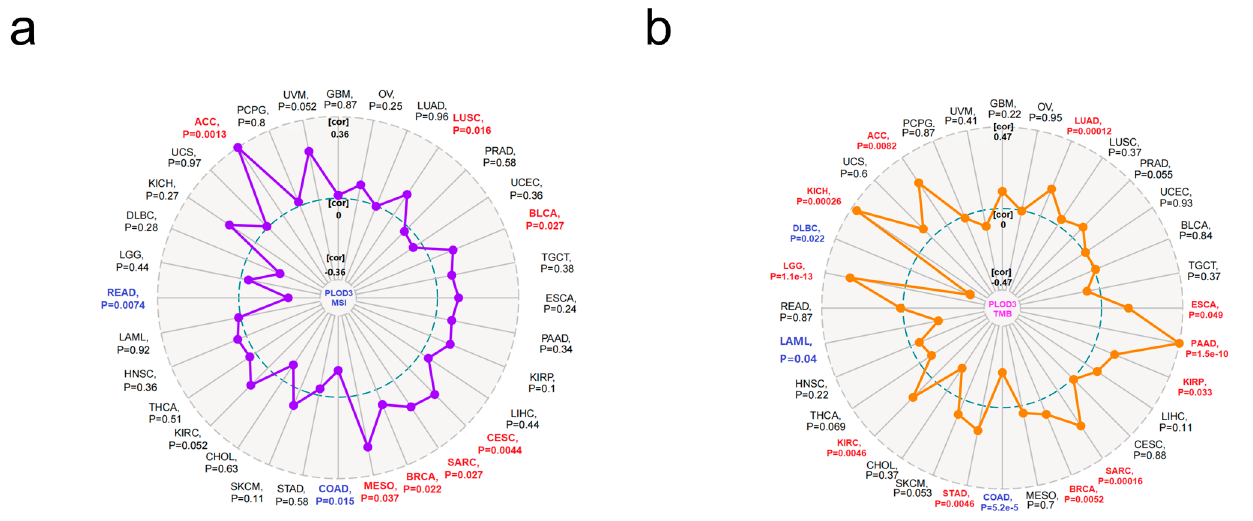
Figure 9. Correlation between PLOD3 expression and microsatellite instability (MSI) or tumor mutational burden (TMB). Based on TCGA database, MSI and TMB were obtained. The p -value is supplied. ( a ) The potential correlation between PLOD3 expression and MSI. The partial correlation (Cor) values of +0.36 and − 0.36 are marked; ( b ) The potential correlation between PLOD3 expression and TMB. The partial correlation (Cor) values of +0.47 and − 0.47 are marked.